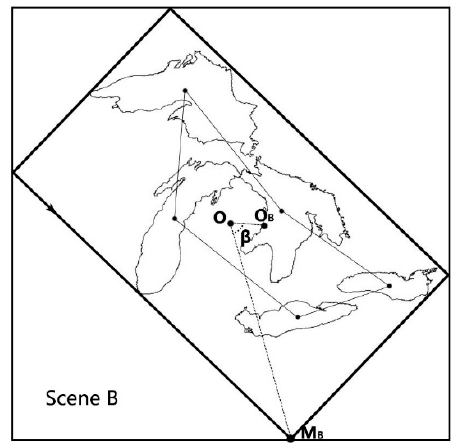
Figure 15. The center angle of Scene B .